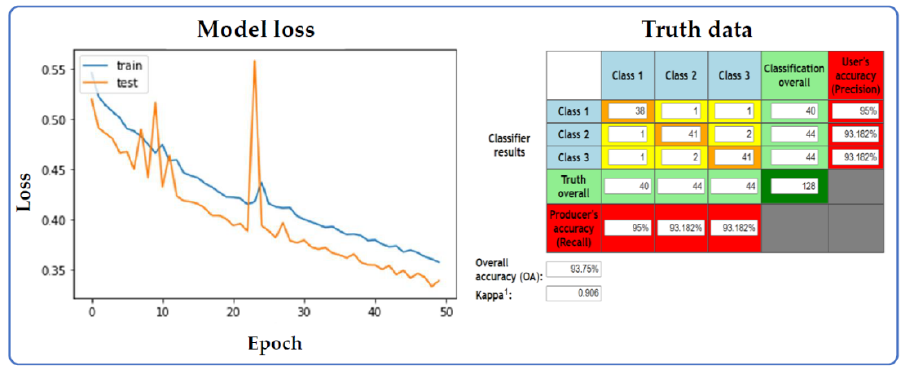
Figure 7. Phase 2 — Model 4 of 21 models: 80 pps, Alpha, Slots 1 vs. 2 – 5 vs. 6 – 8 (pre-stim-post). For this model, the train-to-test ratio was again 9:1, with kappa = 0.906, area under the ROC curve (AUC) = 0.943 and F-measure = 0.938.